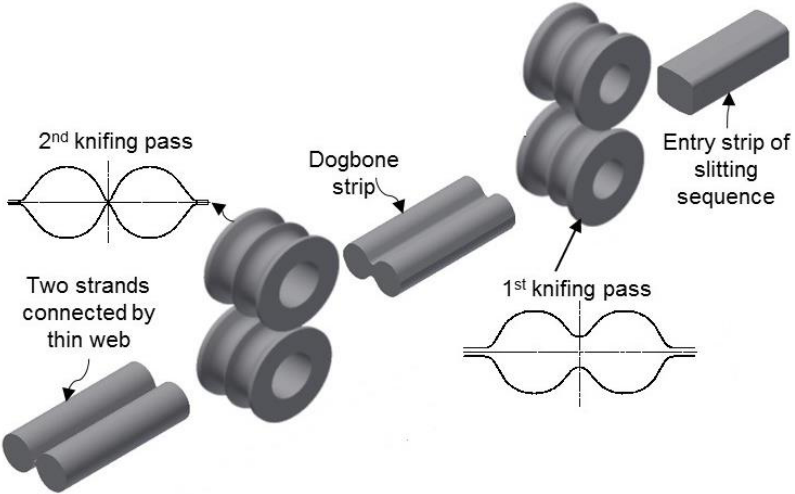
Figure 1. Slitting passes of the single barreled strip first and second knifing type passes in the slit rolling subsequence; commonly named ‘dogbone’ pass and ‘slitting’ pass, respectively.